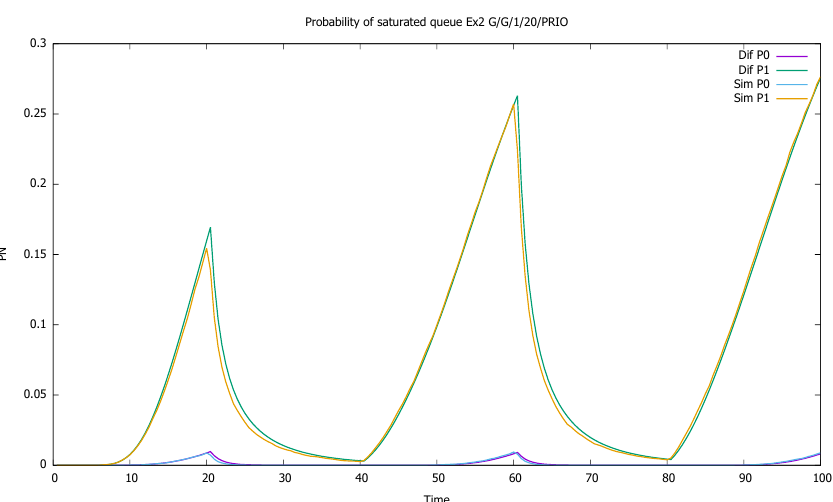
Figure 8. Section 3.2, medium load: probabilities of saturated queues p N ( t ) for priority (P0) and non-priority (P1) classes.